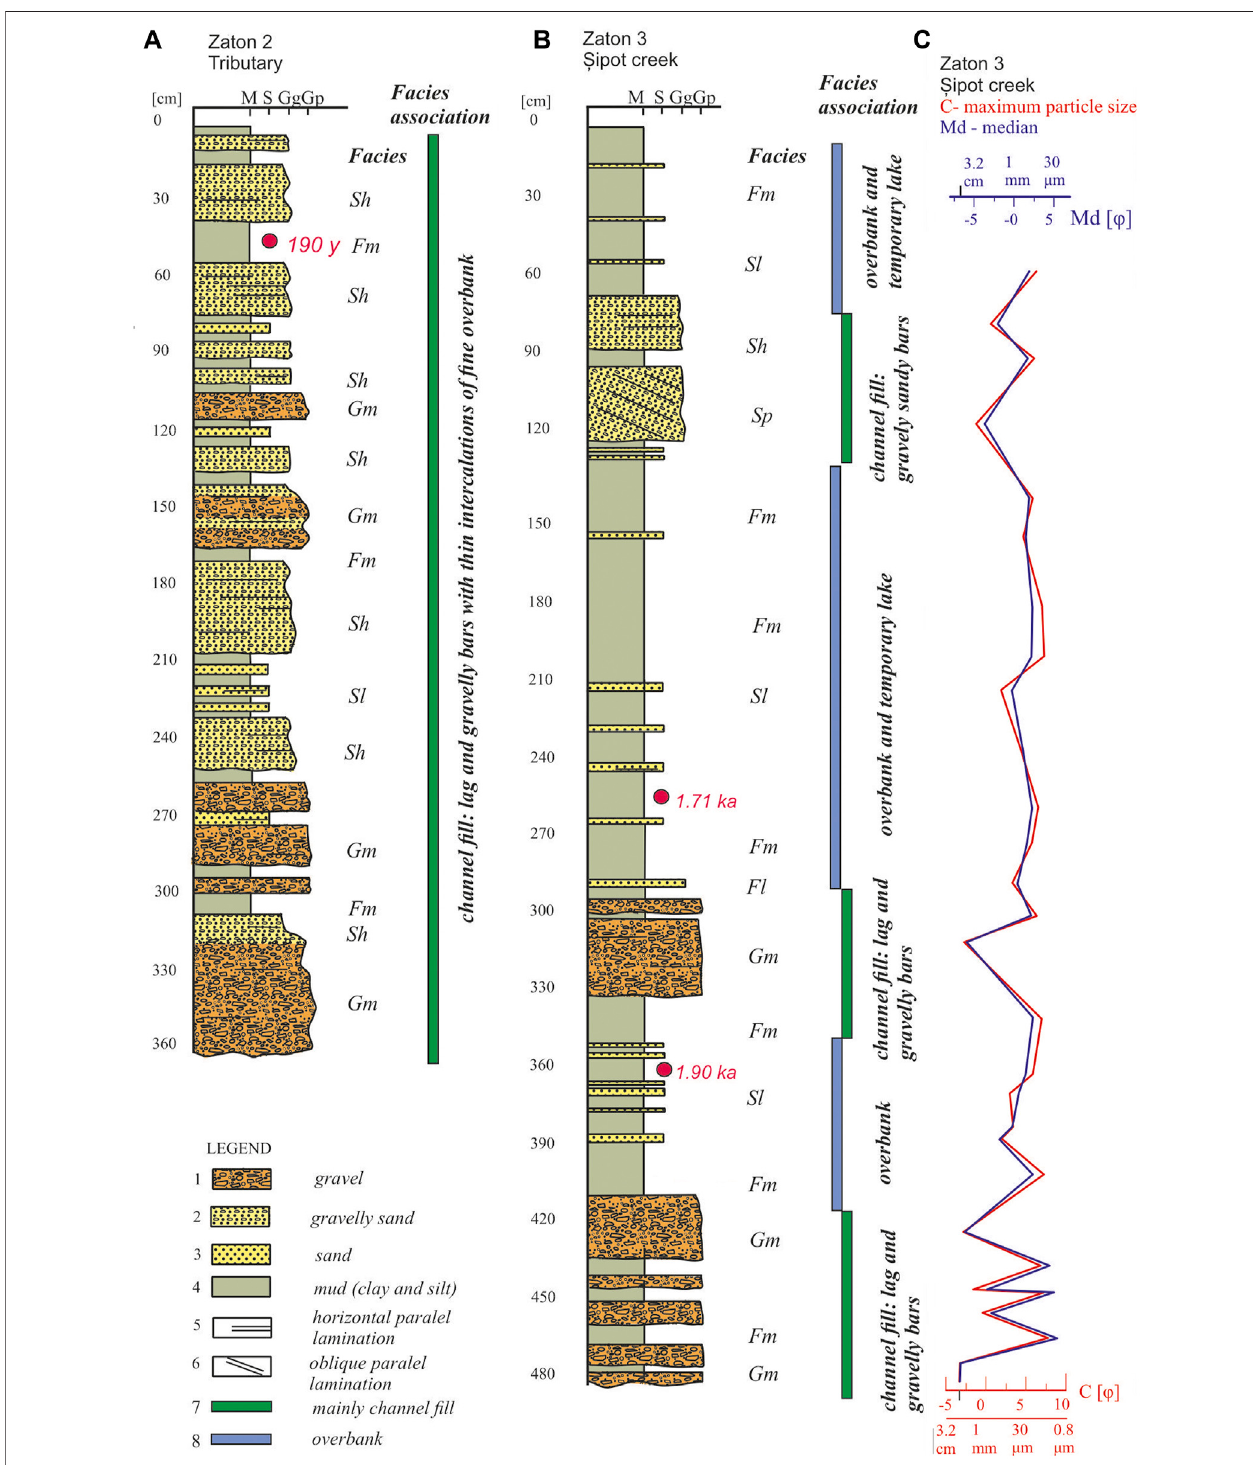
FIGURE 3 | Sedimentological logs of Z ă ton Lake. (A) Zaton2 (see Figure 1E for location). (B) Zaton3. (C) The distribution graph of depth and the granulometric parameters C (maximum particle size) and median (Md). The grain size categories on the top of logs: M – mudstone, S – sand, Gg – gravel (granules: 2 – 4 mm), and Gp – gravel (pebbles: 4 – 64 mm). The facies codes on the right side of the log are described in the text: Gm, Sh, Sp, Fl, and Fm.